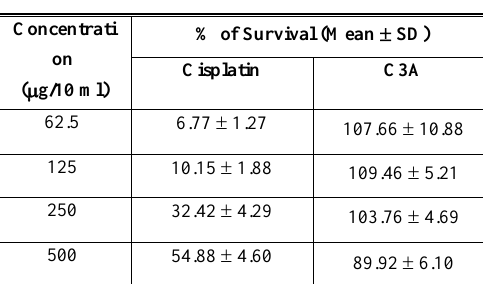
*** Significant difference from cisplatin at p<0.001 Fig 6 : Graphical representation of concentration dependent effect of C3A on HEP-2 cells. Table 3: The cell survival as percentage of the control for the HEP-2 cell when the cell were treated with